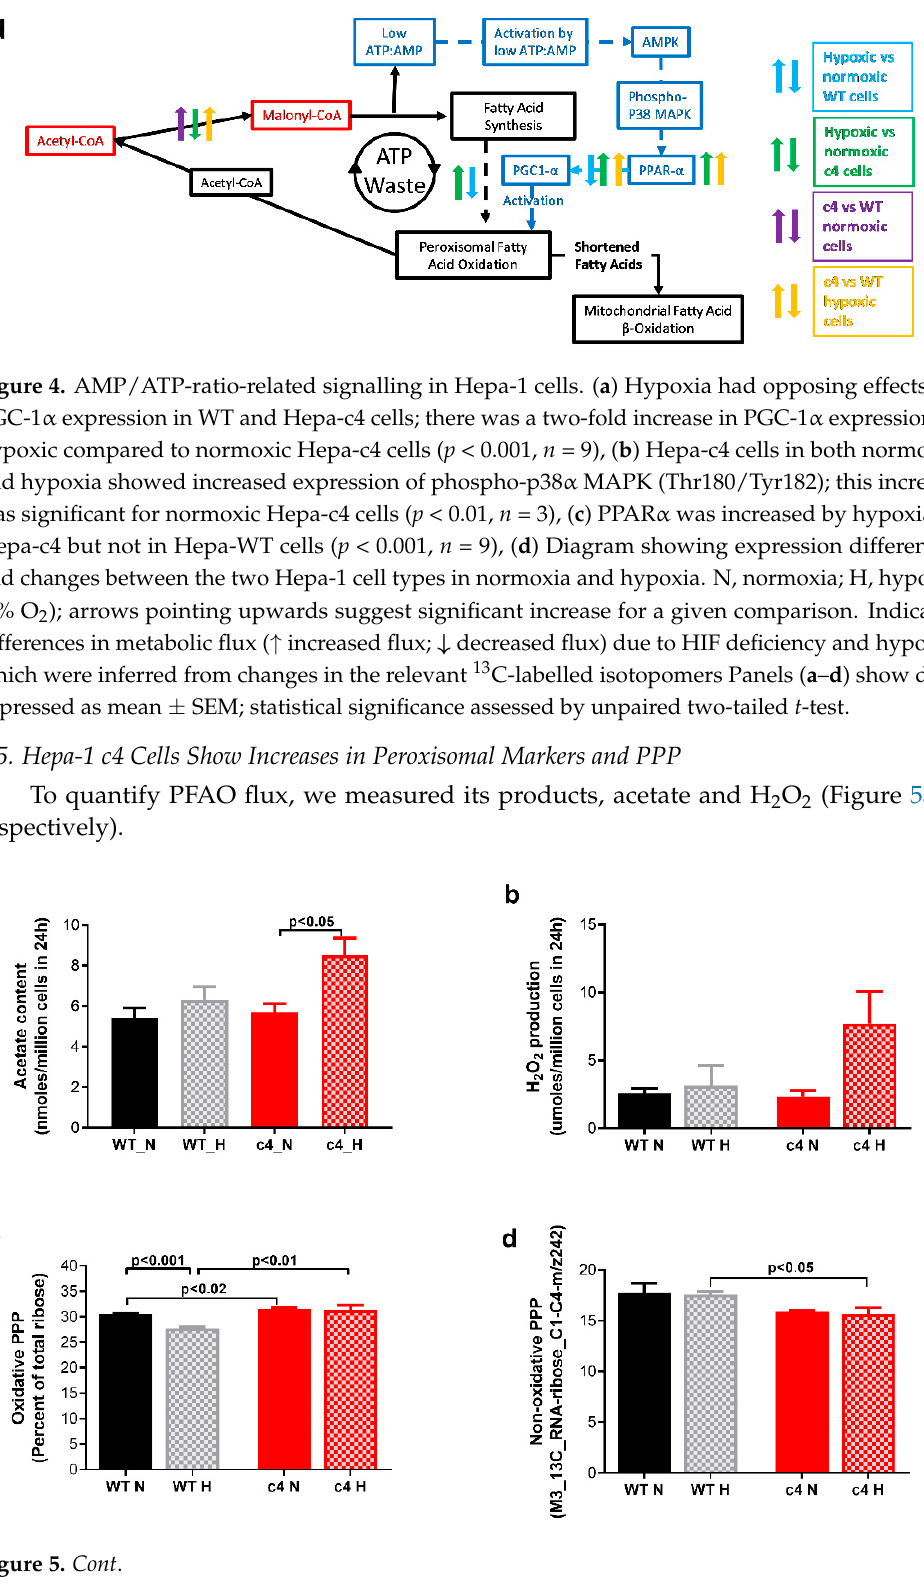
Figure 5. PFAO markers and differences in pentose phosphate pathway flux in Hepa-1 cells. ( a ) Acetate content significantly increased in Hepa-c4 cells in response to hypoxia ( p < 0.05, n = 5). ( b ) Hypoxic Hepa-c4 cells released more hydrogen peroxide into the media ( p < 0.05, n = 5) ( c ) Nucleic acid ribose synthesis via the oxidative pentose phosphate pathway was higher in Hepa-c4 than WT cells in both normoxia and hypoxia ( p < 0.02 and p <0.01, respectively, n = 4). ( d ) Nucleic acid ribose re-assembly via the non-oxidative pentose phosphate pathway was slightly lower in Hepa-c4 than WT cells ( p < 0.05), but was not substantially affected by hypoxia in either cell line. ( e ) Diagram showing flux differences and changes between the two Hepa-1 cell types in normoxia and hypoxia.